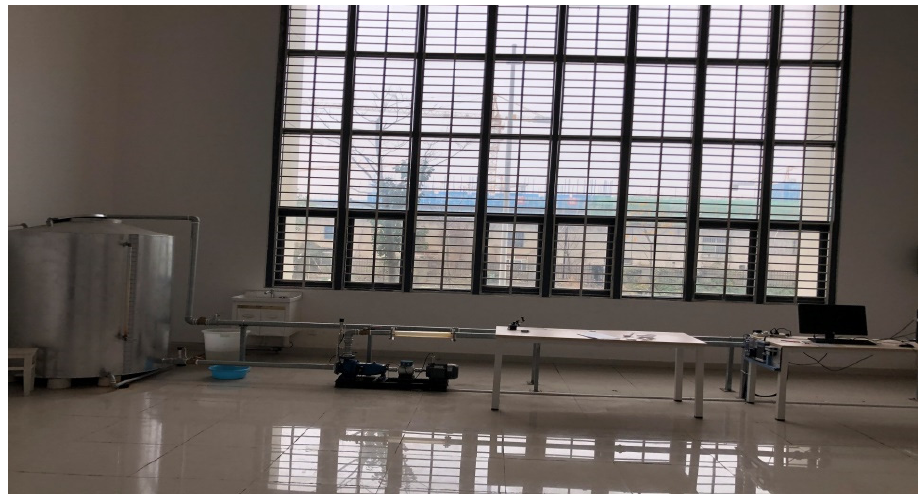
Figure 1. Laboratory centrifugal circulating water pump device.